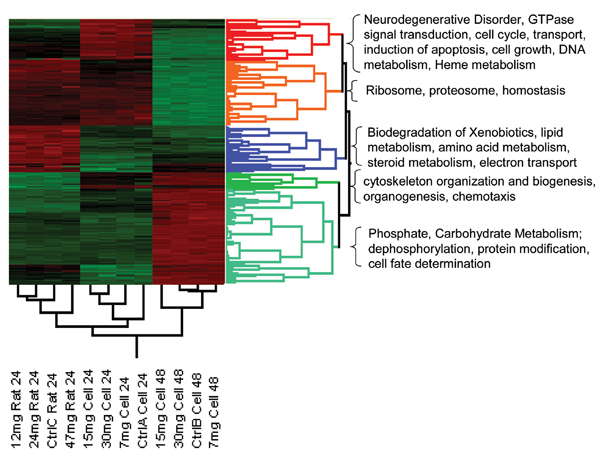
Hierarchical clustering of significant differentially expressed genes according to Bonferroni correction, total 2929 genes. Red represents up and green represents down-regulated genes relative to the mean of all samples. Cluster enriched GO terms are listed adjacent to each cluster.